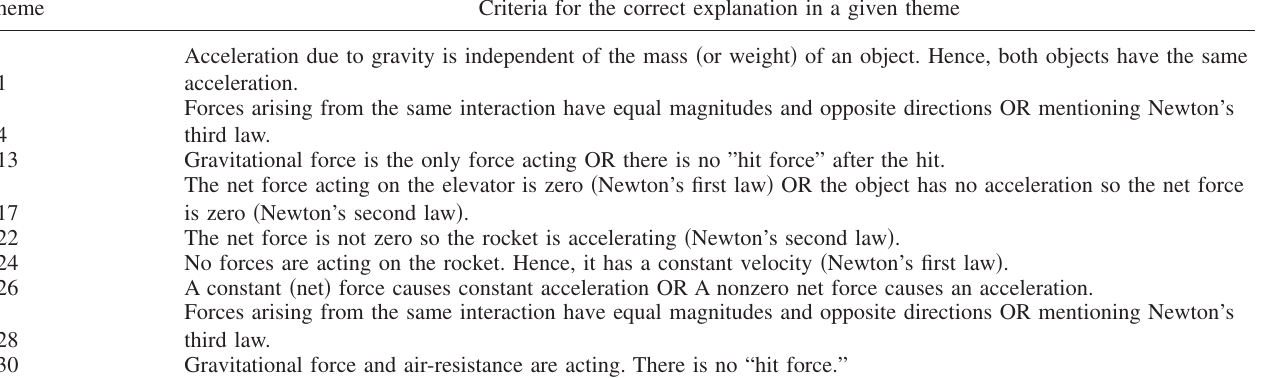
TABLE XI. Validation